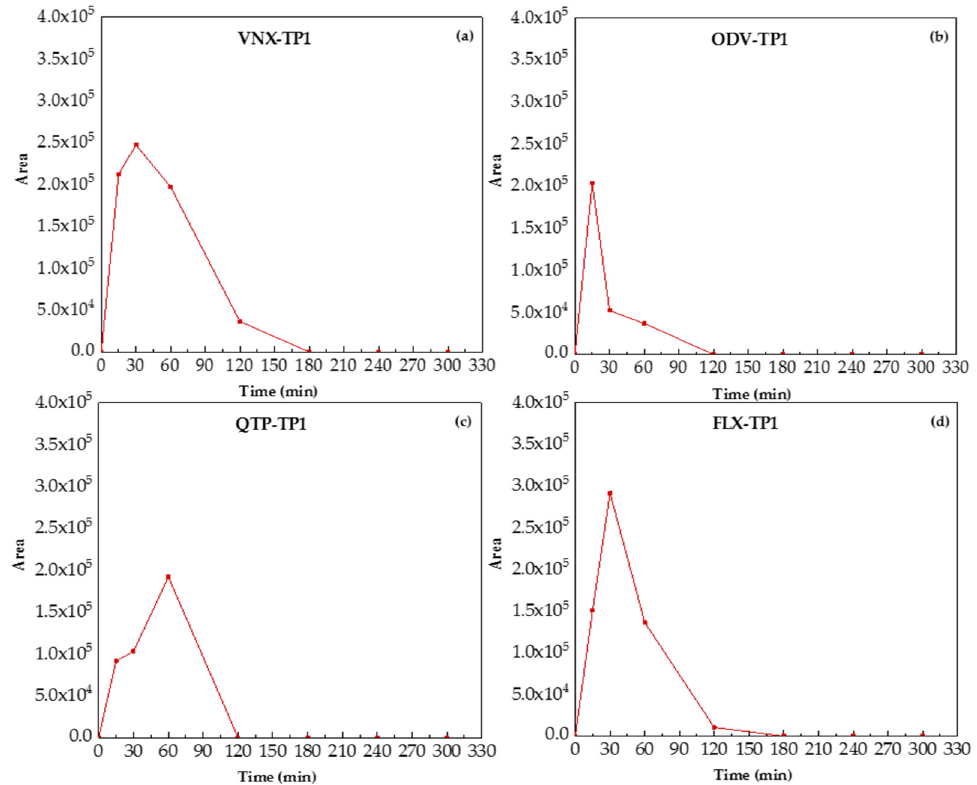
Figure 2. Evolution profiles of ( a ) venlafaxine TP1, ( b ) O-desmethyl venlafaxine TP1, ( c ) quetiapine TP1, and ( d ) fluoxetine TP1, formed by photocatalytic oxidation process at the laboratory-scale pilot plant using 1MoS 2 /g-C 3 N 4 .